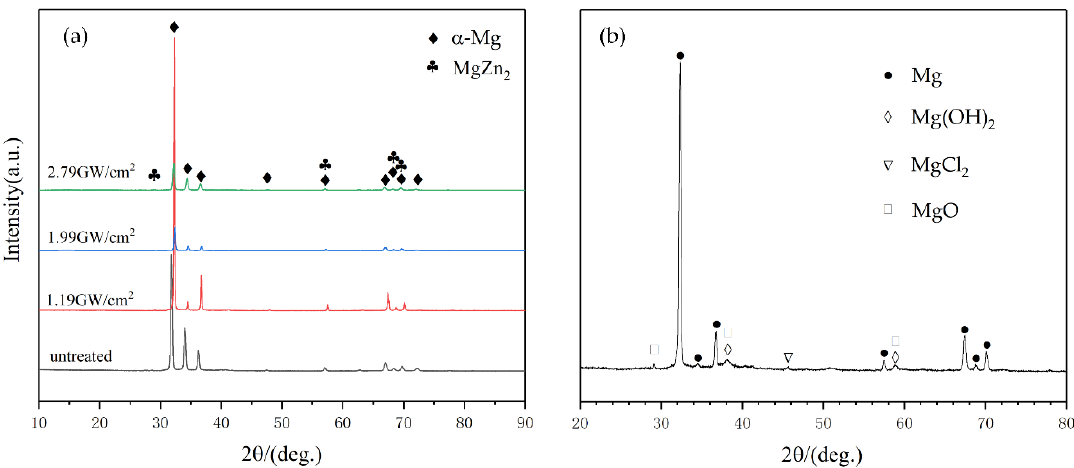
Figure 13. XRD patterns before and after corrosion: ( a ) The change of phase before and after LSP; ( b ) XRD pattern of corroded surface.